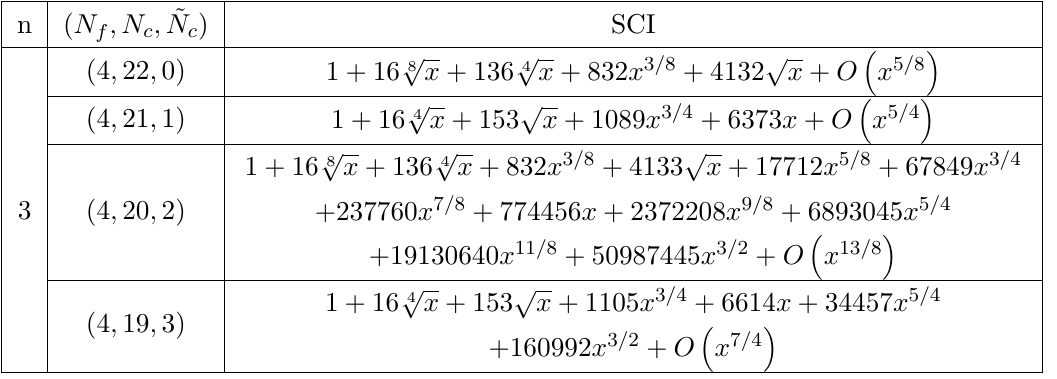
Table 7 . The superconformal index results for the double adjoint theories with ∆ W A = V + Here we list a few examples with ( n, N given in appendix B. The SU( N gauge rank of the dual theory is given by ˜ N